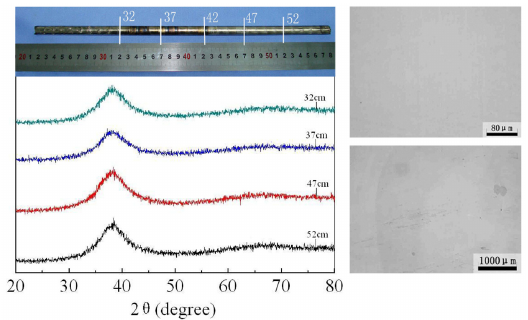
Figure 7. XRD patterns of samples from different positions of Zr